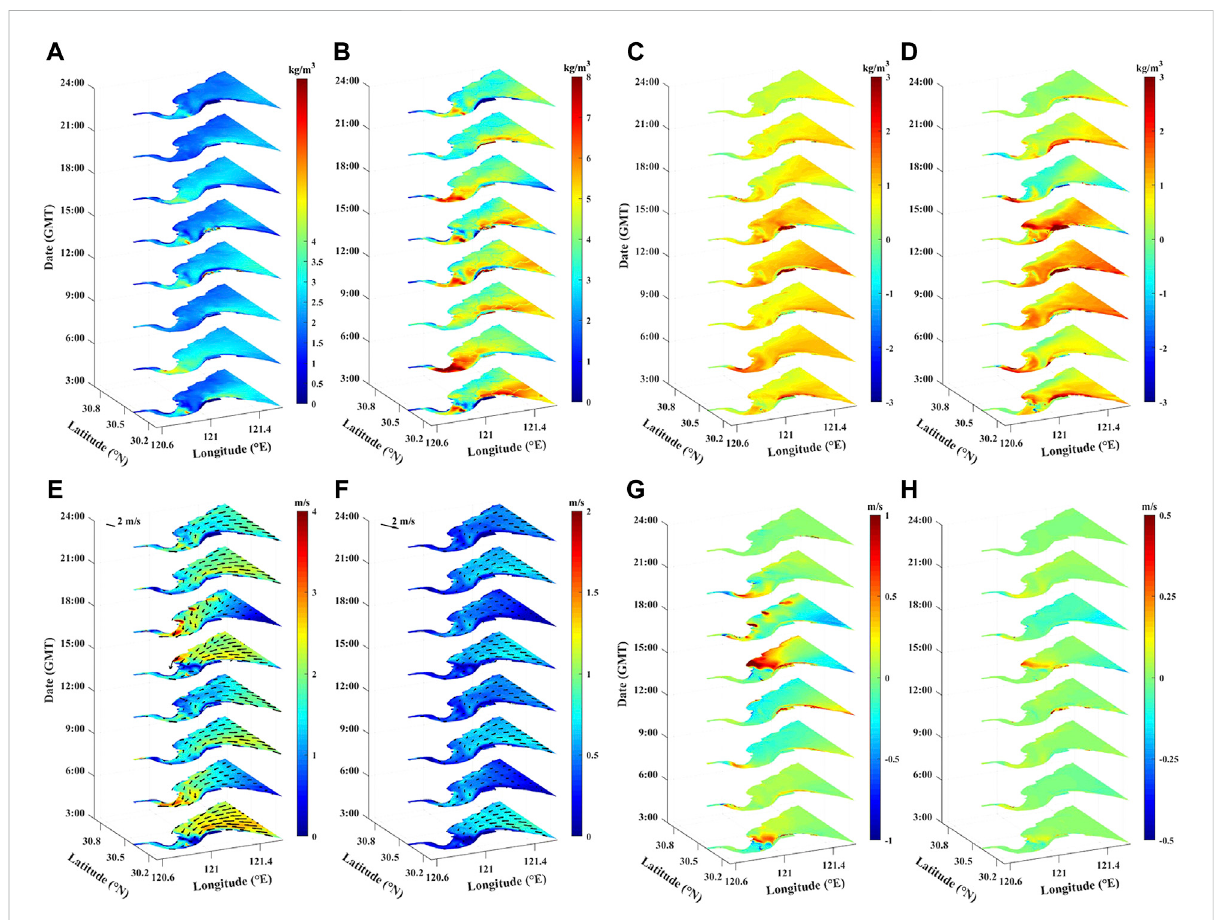
FIGURE 6 Distribution of SSC. (A) Surface layer and (B) bottom layer. (C,D) are the same as (A,B) except for difference in SSC between the test with Typhoon Mitag and the test with only tidal forcing (GMT 1 October 2019, 3:00 – 24:00). (E – H) are the same as (A – D) except for